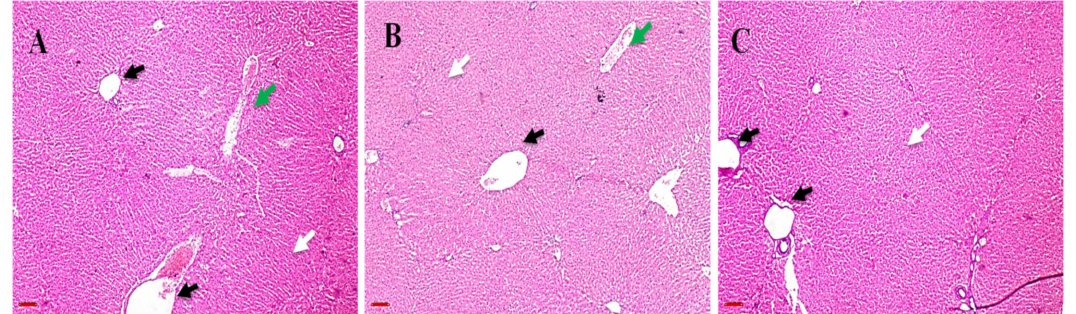
Figure 10. Representative images of H and E stained photomicrographs of liver for one representative rabbit after irritation test for ( A ) Group I; untreated group, act as a control, ( B ) Group II; rhamnolipids nano-micelles solution dispersed in PBS (10 mM, pH 7.4) treated group, and ( C ) Group III; PBS (10 mM, pH 7.4) treated group. All groups treated with samples showed normal histological tissue identical to untreated group after 72 h of treatment with samples. The black arrow points to hepatic central vein, the green arrow points to portal triads, and the white arrows point to hepatocytes. Scale bar, 100 µ